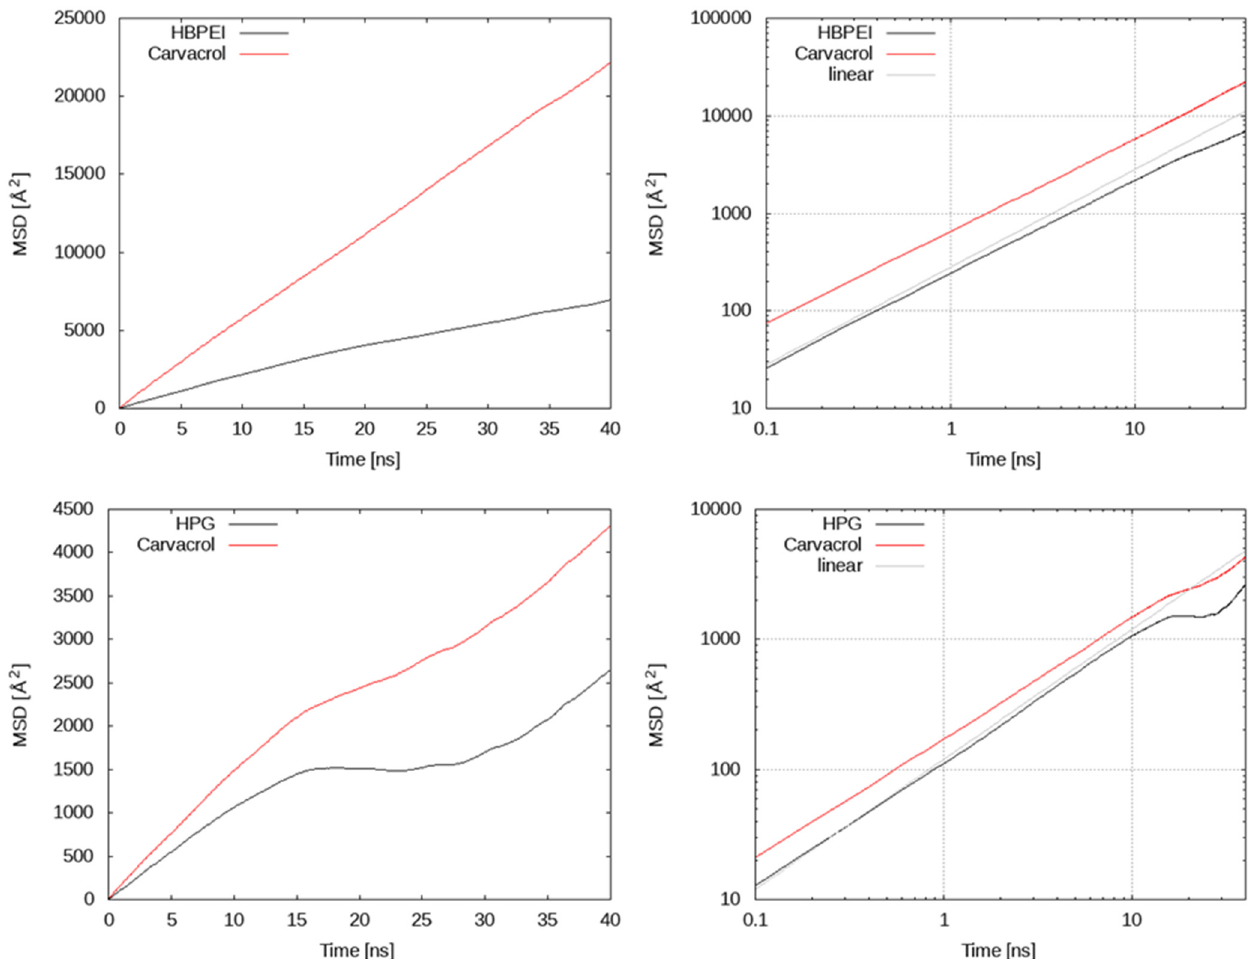
Figure 8. Mean square displacement in linear (left) and log–log (right) scales of polymer and carvacrol species in 27-polymer chain systems of HBPEI–carvacrol (top row) and HPG–carvacrol (bottom row).